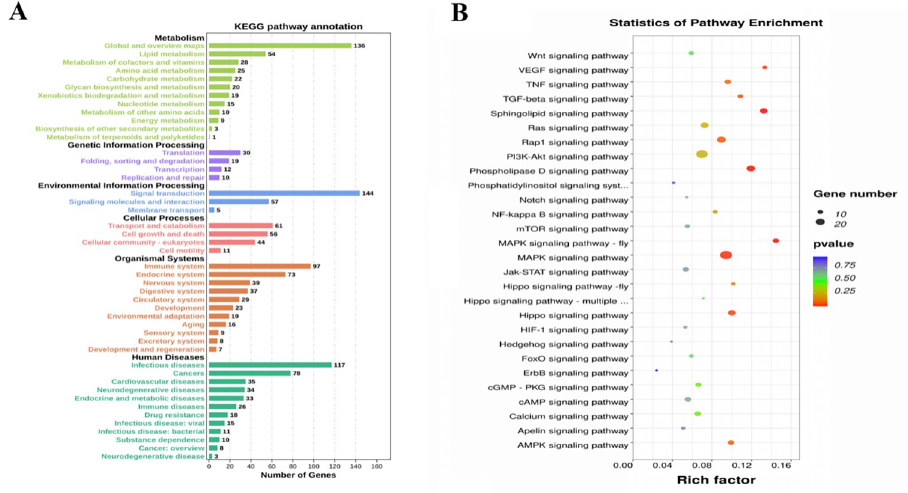
Fig 5. KEGG analysis of DEGs. ( A ) Primary and secondary KEGG classifications of DEGs. ( B ) Twenty-eight signaling pathways in environmental information processing. The circle size represents the number of genes and the color signifies P